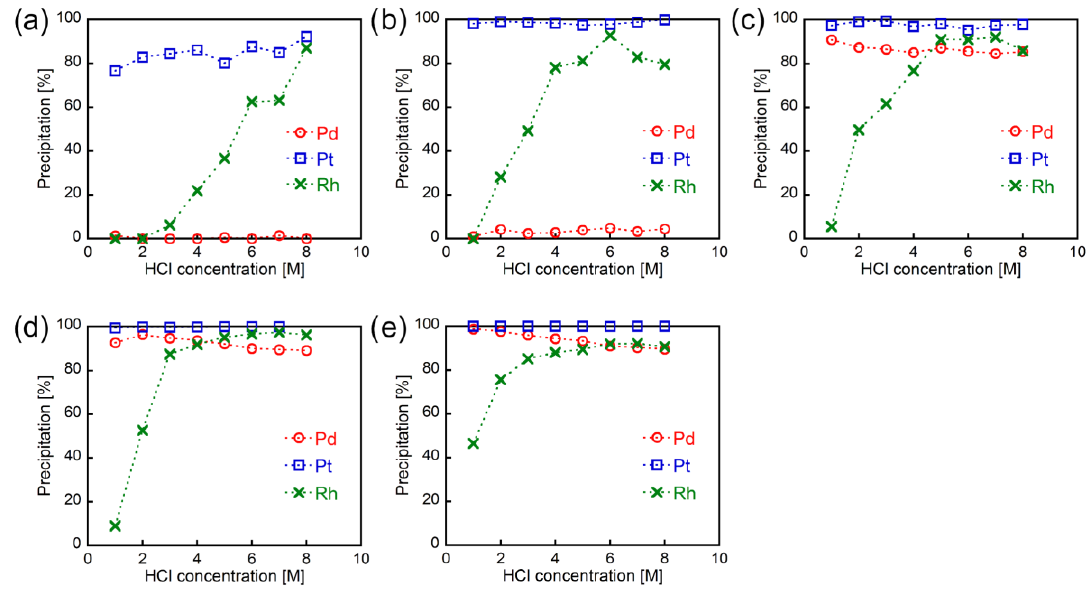
Figure 1. Metal precipitation from HCl solutions containing Pd(II), Pt(IV), and Rh(III) (each at 1 mM) using ( a ) n -heptylamine, ( b ) n -octylamine, ( c ) n -nonylamine, ( d ) n -decylamine, and ( e ) n -dodecylamine (amine: 50 mM, 30 min of shaking).